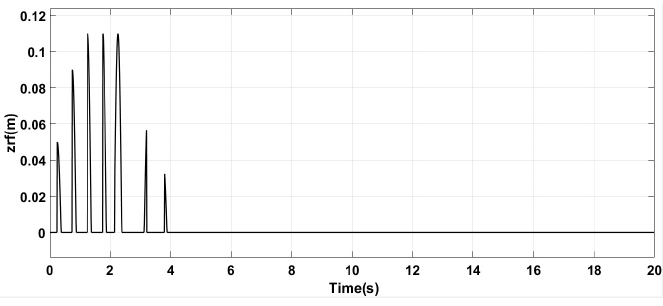
Figure 4. Front Road